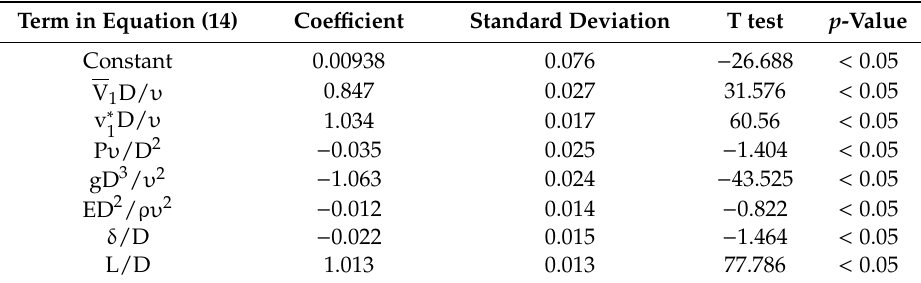
Table 5. Results of regression analyses for all the terms in Equation (14).